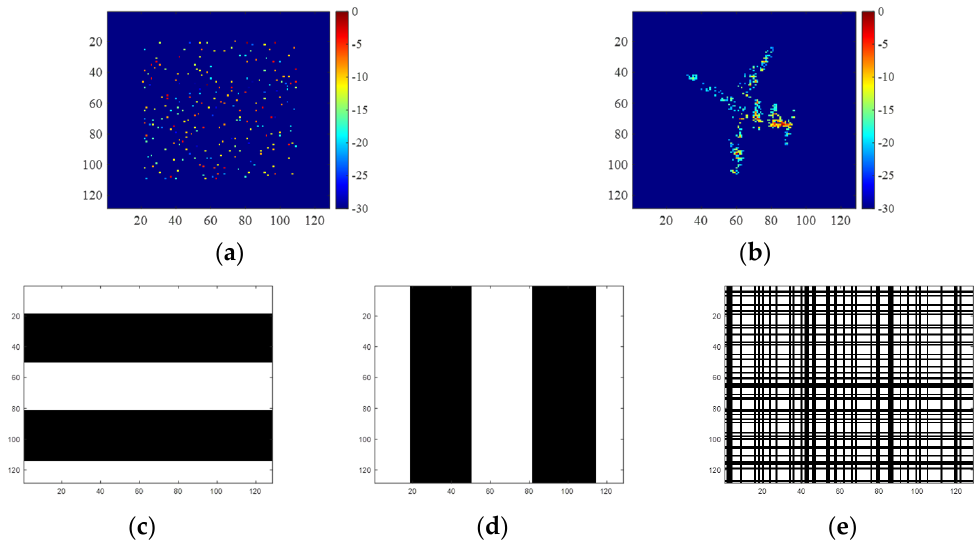
Figure 8. ( a ) Label image of a test sample. ( b ) RD image of the Yak-42 aircraft with complete data and high SNR. ( c ) Data missing pattern of the incomplete range data. ( d ) Data missing pattern of the incomplete azimuth data. ( e ) Data missing pattern of the 2D incomplete data.